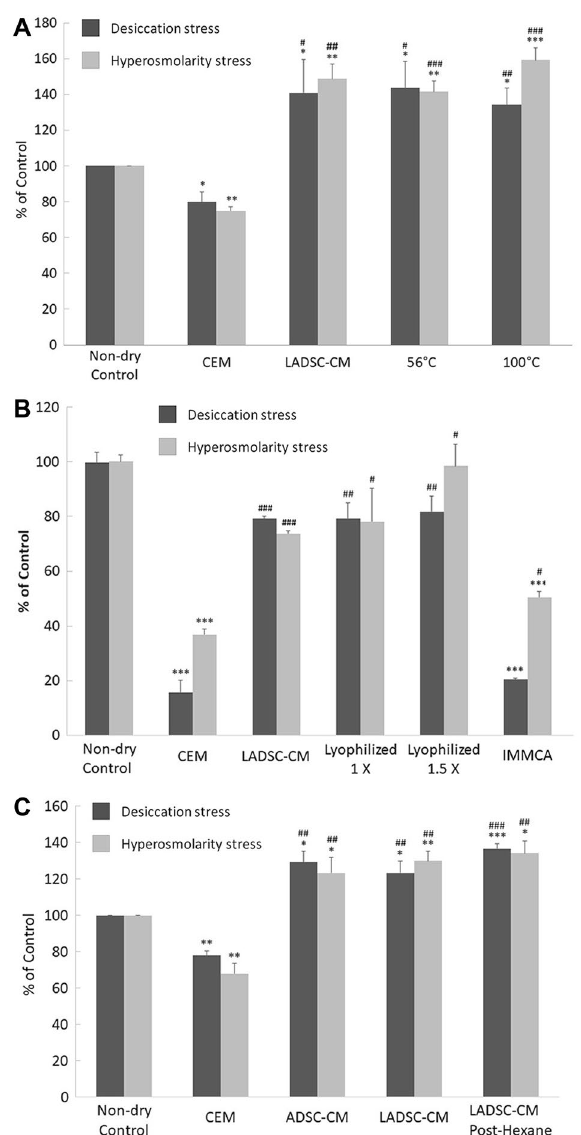
Figure 7. Protective effects of LADSC-CM on HCECs in desiccation stress or hyperosmolarity stress. (A) Heating to 56 °C for 30 min or 100 °C for 3 min did not reduce the protective effects of LADSC-CM. (B) The defensive capabilities after lyophilization, storage, and reconstitution were similar to those before the process. (C) An equal volume of hexane extraction three times did not change the protective effects of LADSC-CM (N = 5 in each